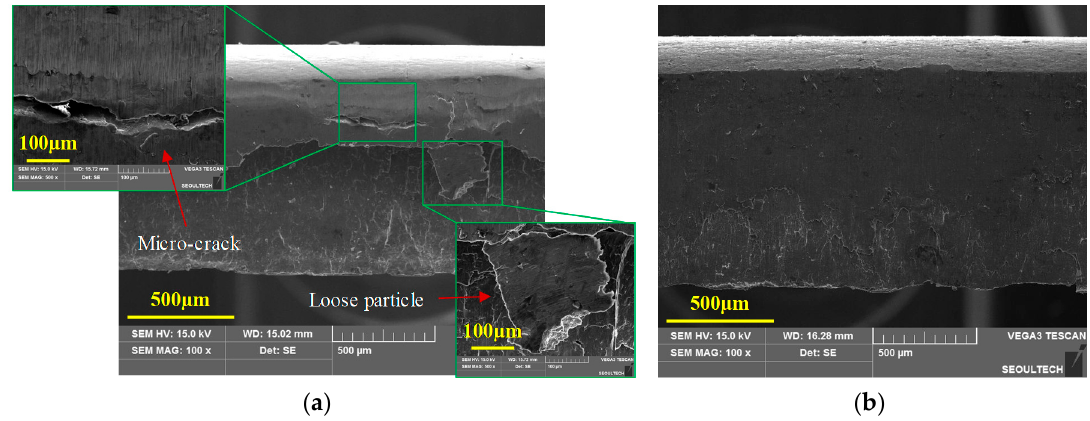
Figure 13. Front view (SEM) of the blanked edge obtained from experiments for 20% clearance at ( a ) 25 °C, illustrating micro-crack in the burnish zone and loose particles, and ( b ) 250 °C, illustrating positively improved sheared edge.